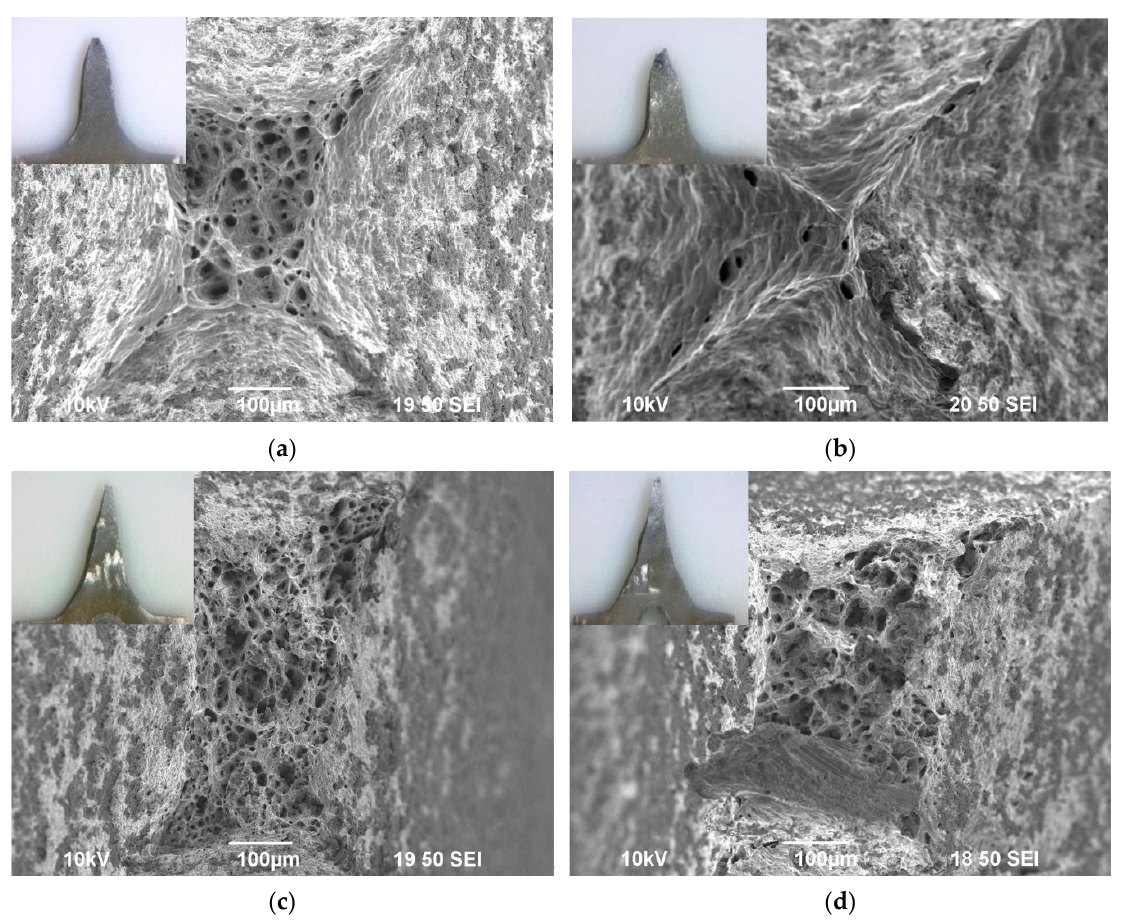
Figure 7. The effect of strain rate on σ ( ε ) curves in UFG alloy Nos. 2 ( a ), 5 ( b ), 7 ( c ), and 8 ( d ). Numbers near σ ( ε ) curves indicate strain rates at 500 °C.